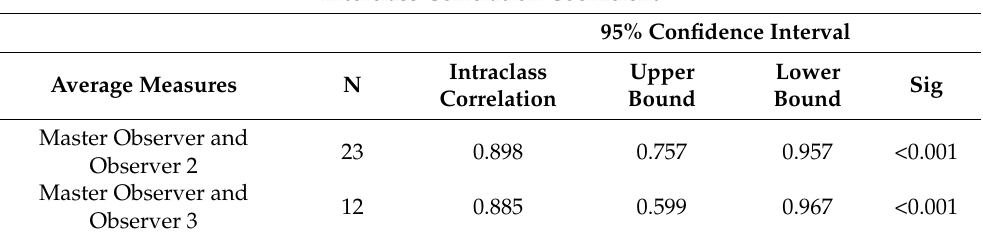
Table 1. ICC of MPOT.